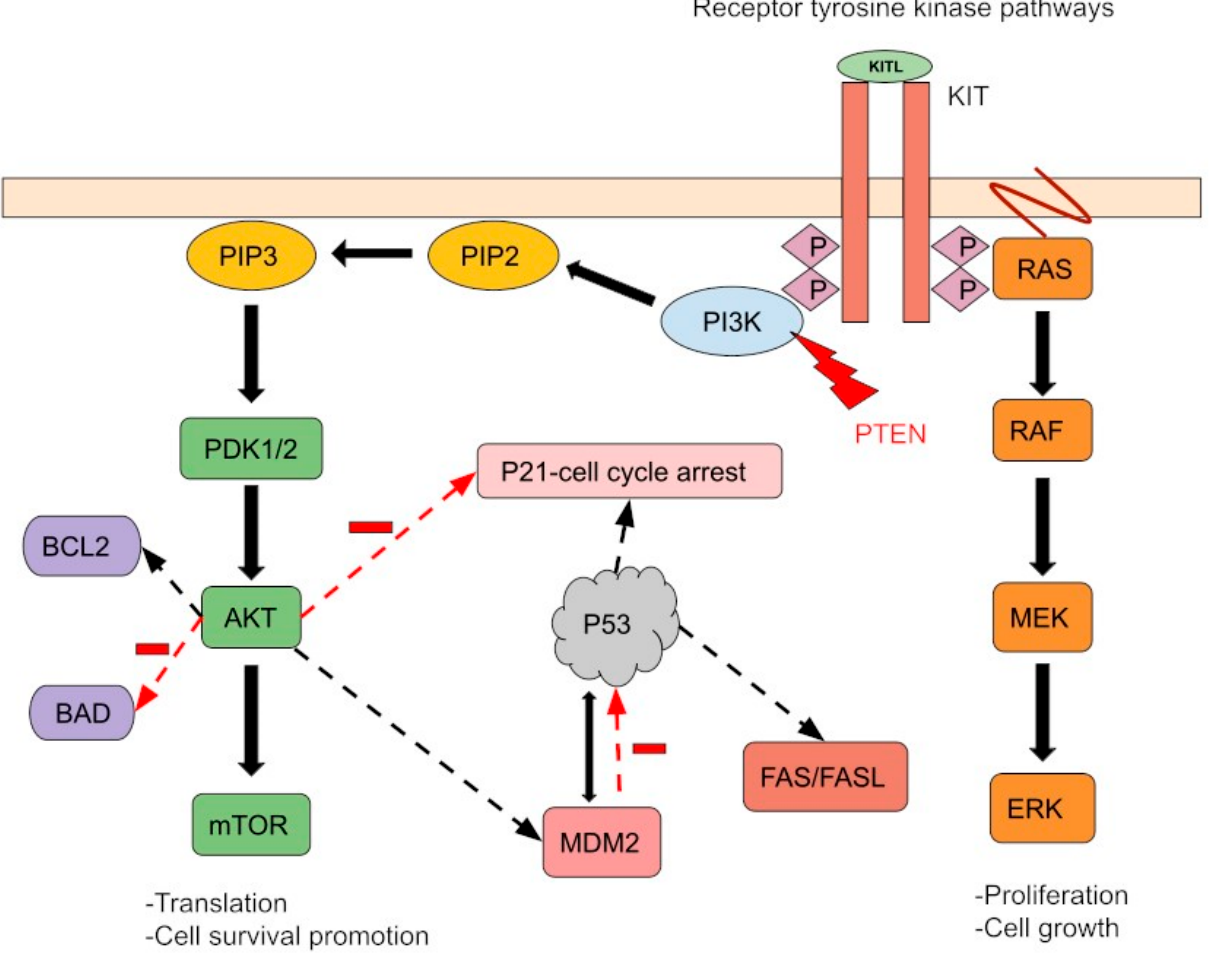
Figure 1. A simple schema of molecular aberrations in PMGTs. The most common mutations described in PMGCTs are TP53 (46%), c-KIT (18%), KRAS (18%), PTEN (11%), NRAS (4%), and PIK3CA (4%). K-RAS and N-RAS mutations cause Ras-Raf-MEK-ERK pathway activation regardless of re- ceptor activity. The PTEN tumor suppressor gene controls cell growth and migration. Its mutation activates the PI3K pathway, leading to impaired mitotic arrest and cell survival promotion. MDM2